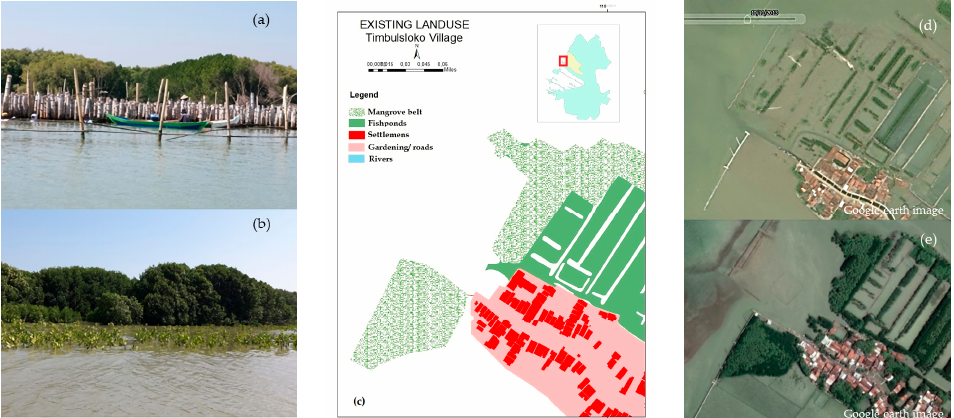
Figure 9. An example of how the cultivation of the fishponds can be implemented with environmental adaptation: ( a , d ) the hybrid engineering technique, developed as trap sediments; ( b ) mangrove belt development as a protection zone for fishpond culture and rural community activities; ( c ) spatial illustration of Timbulsloko in applying hybrid technology and silvofisheries; ( e ) how the mangrove belt and silvofisheries have been developed.